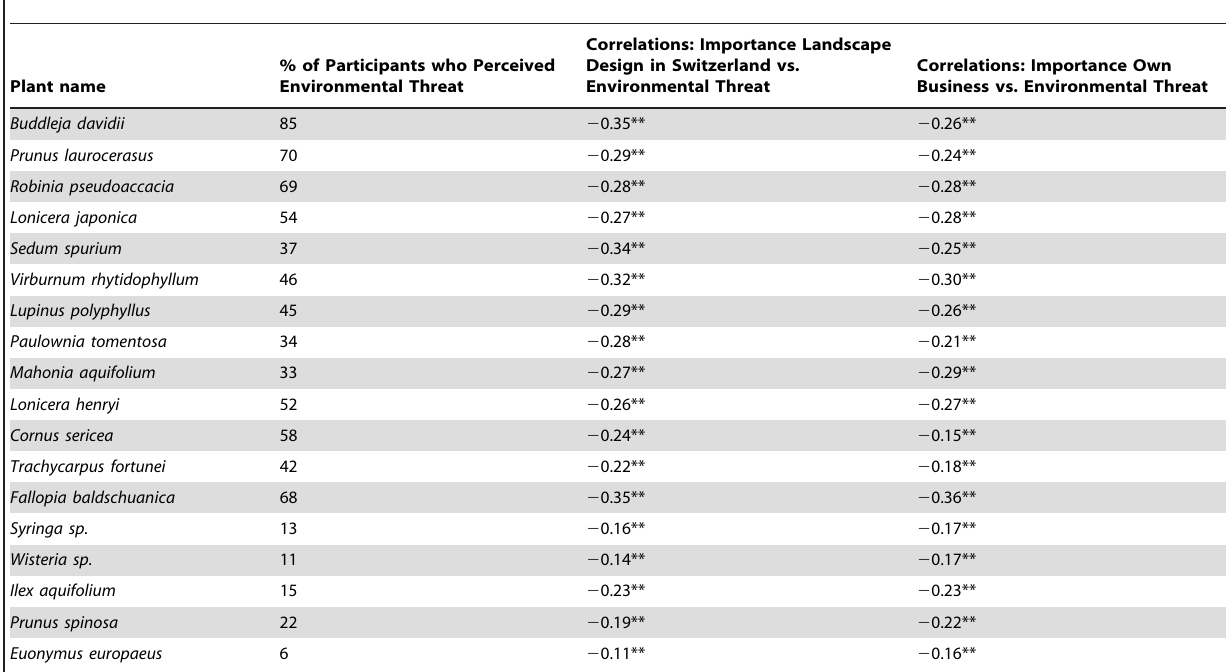
Table 4. Descriptives of variable perceived environmental threat if not handled correctly and point-biserial correlations between perceived importance and perceived environmental threat.